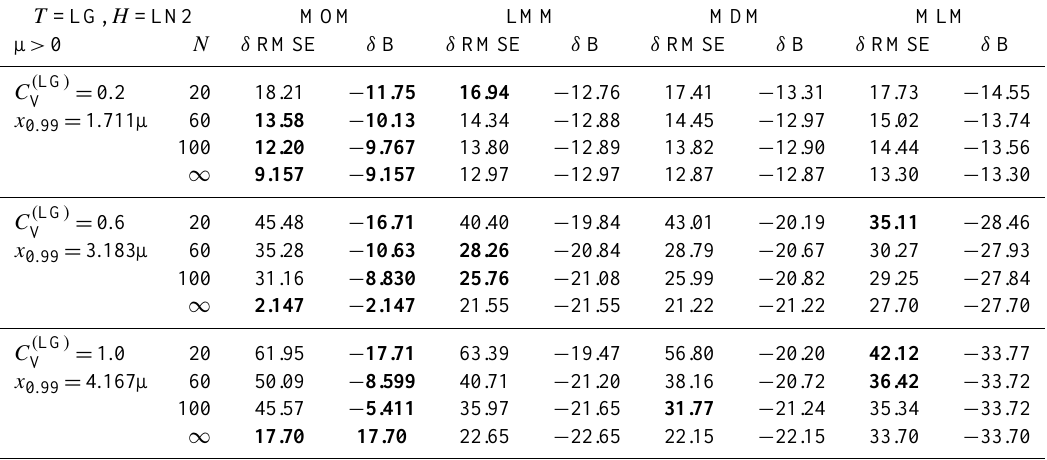
Table 8. Relative accuracy [ % ] of ˆ x 0 . 99 for a sample from LG, assuming LN2